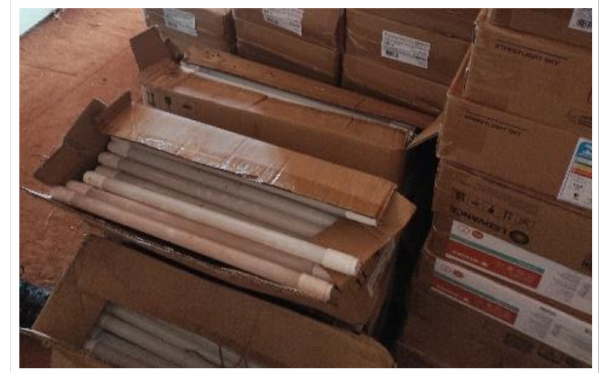
Figure 5. Lamps and Electronic Ballasts Removed for Disposal.